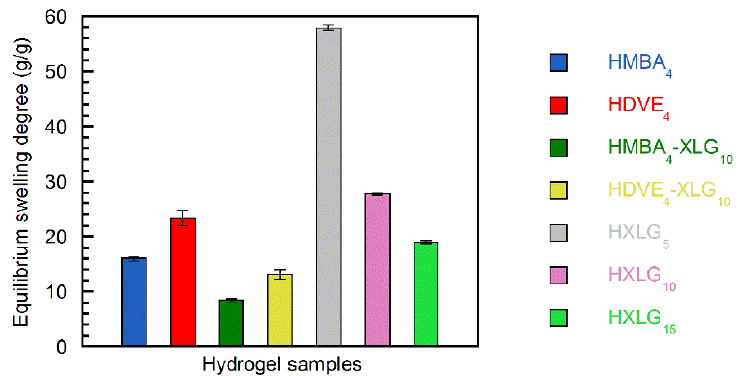
Figure 8. Equilibrium swelling degrees of the hydrogel samples synthesized.